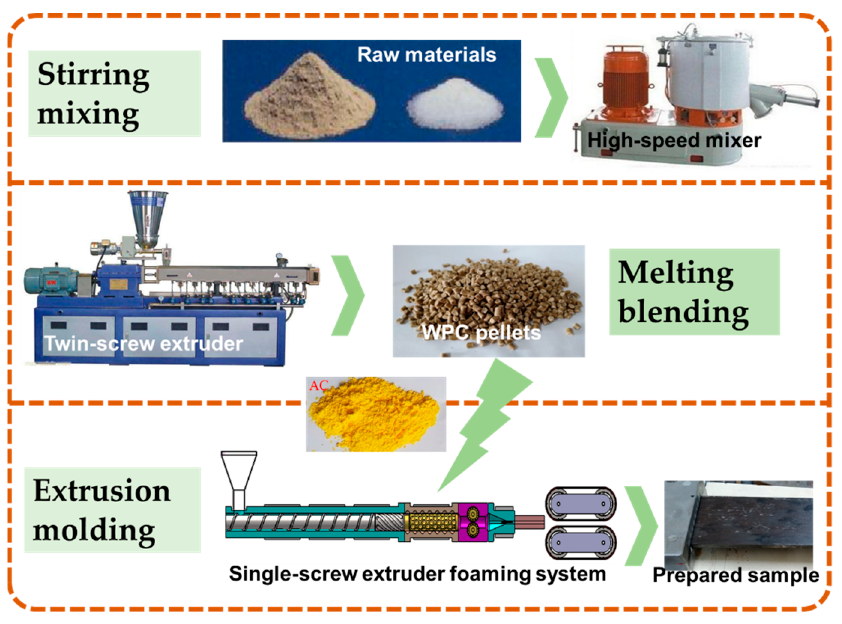
Figure 3. Preparation process of PP-based WPCs.